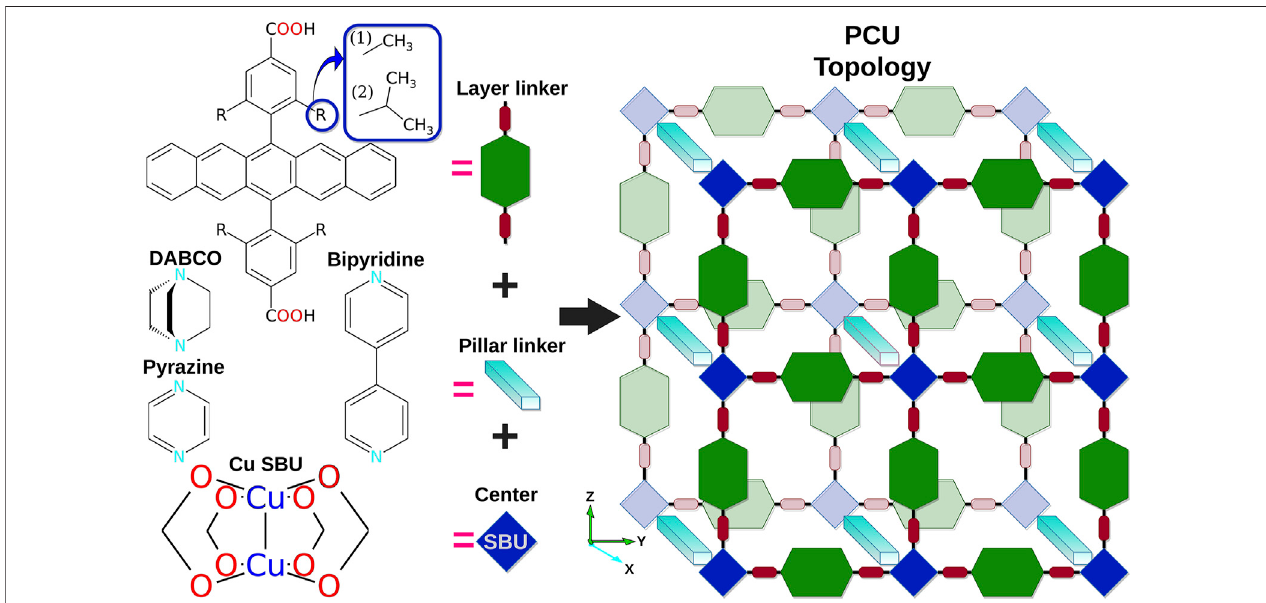
FIGURE2| RepresentationofMOFmaterialsofPCUtopologyinvestigatedinthepresentreport.Layerandpillarlinkersaremarkedingreenandcyan,respectively. Copper secondary building units (SBUs) are depicted in blue.